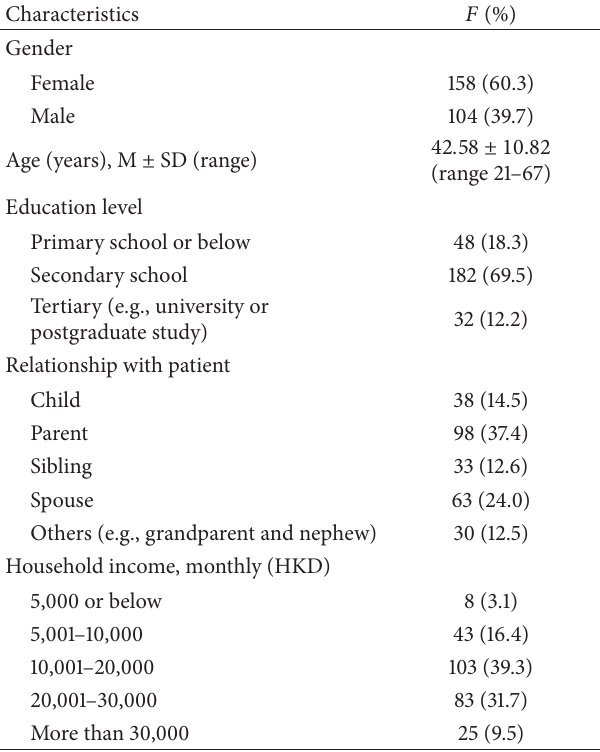
Table 2: Characteristics of family caregivers ( 𝑁 = 262